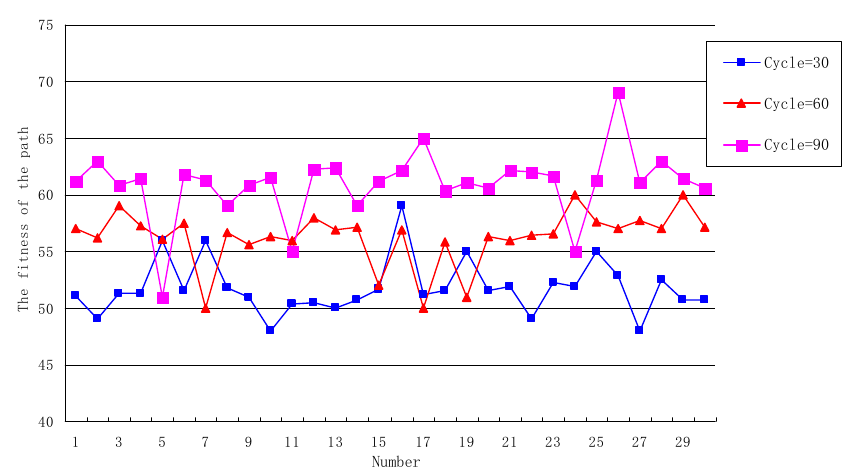
Figure 7. The fitness of the path when the number of Cycle is different.